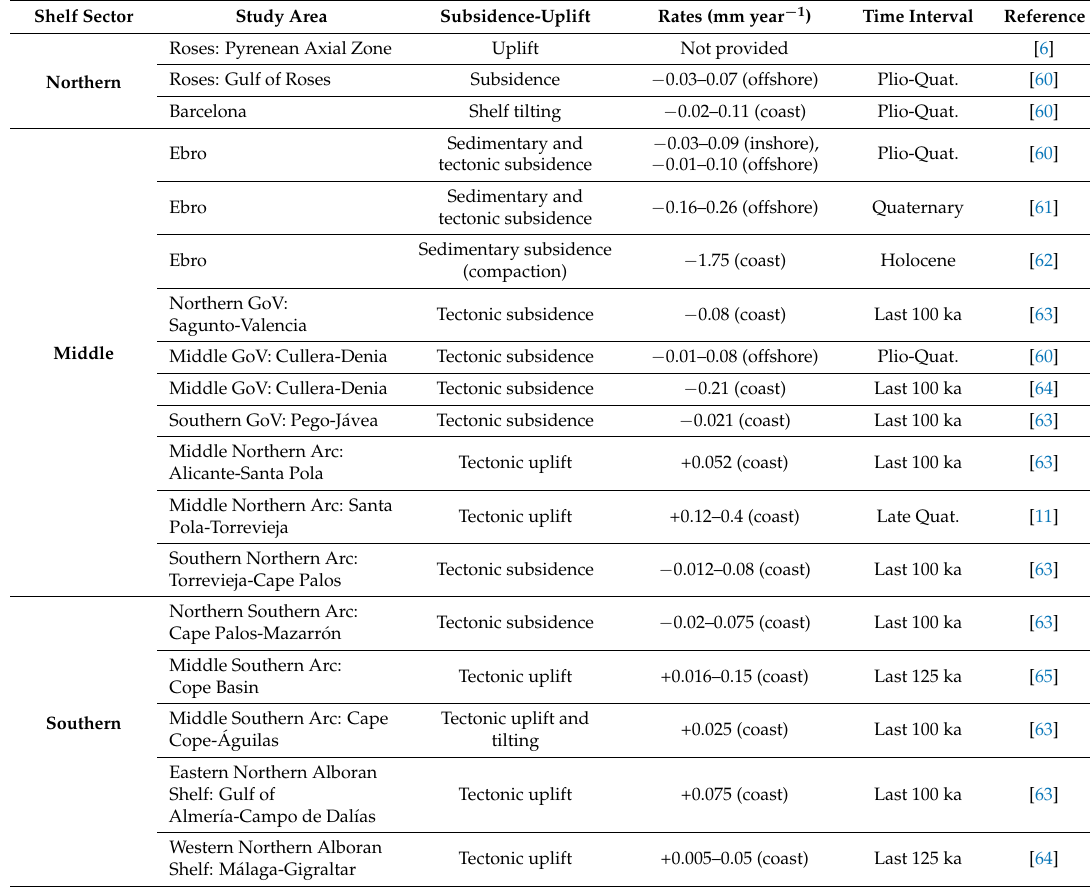
Table 5. Compilation of subsidence ( − )/uplift (+) values documented along the Iberian Mediterranean margin, either inshore, at the coast or